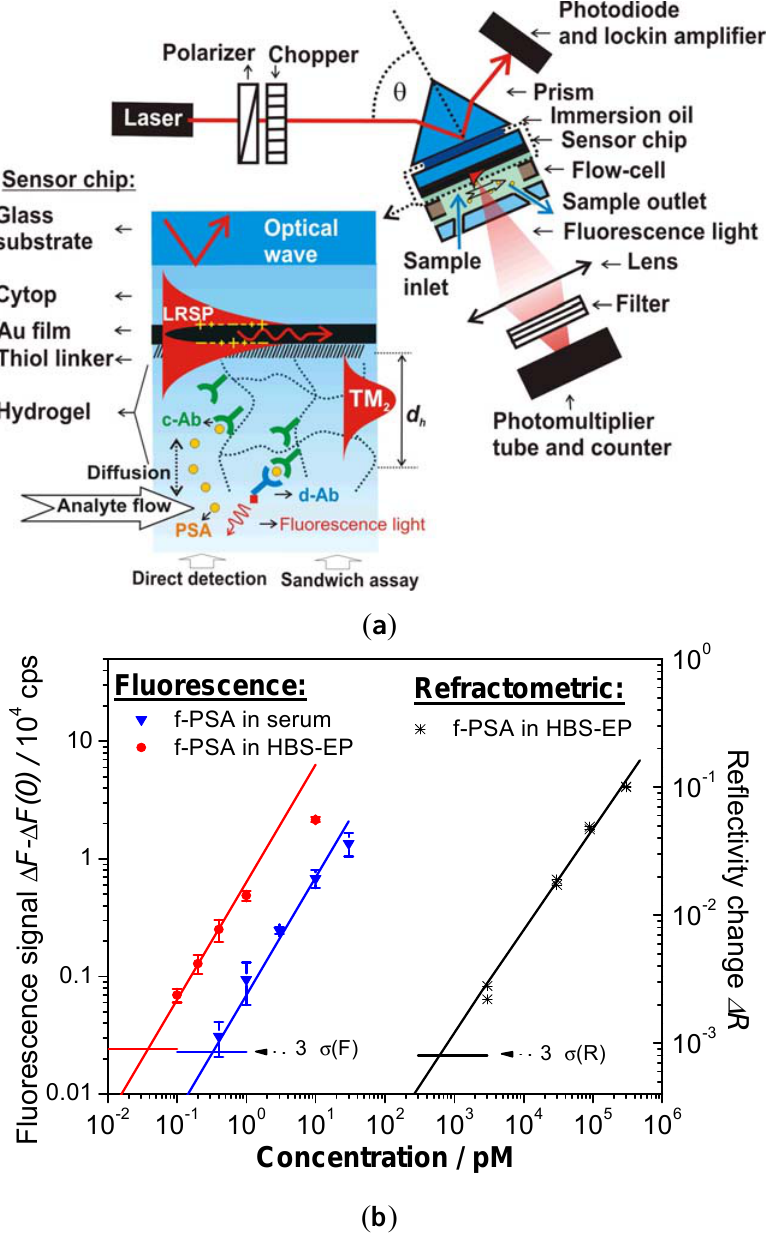
Figure 10. ( a ) Optical setup for the excitation of long range surface plasmons (LRSPs) on the sensor surface with photo-crosslinked carboxymethyl dextran hydrogel binding matrix for sandwich immunoassay detection of f-PSA. ( b ) Calibration curves measured for direct and fluorescence-based detection of f-PSA in a buffer (HBS-EP) and human serum (Reproduced with permission from